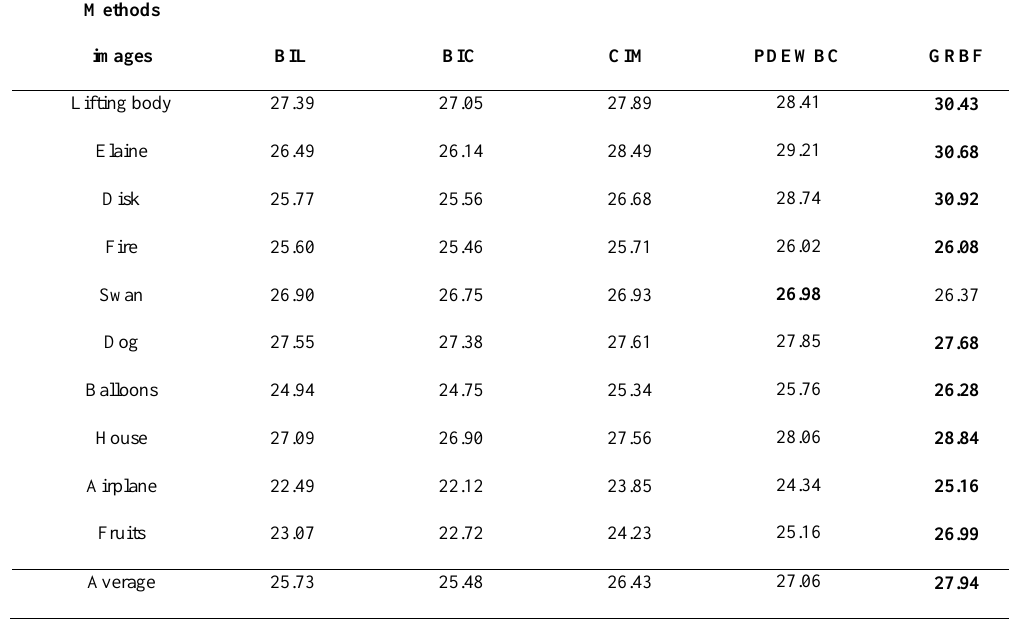
Table 6. Results of running GRBF using PSNR, with edge correction and compare other methods by factor of 4 in zooming.